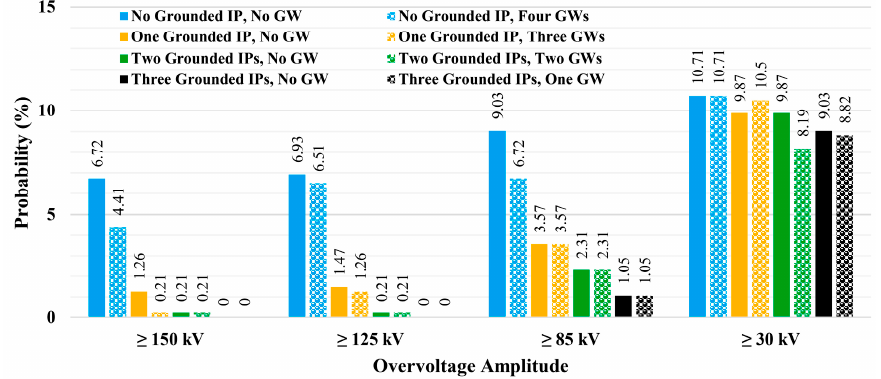
Figure 24. Comparison among the probabilities of transformers experiencing four overvoltage stress levels under different combinations of grounding and guy wire (GW) configurations of intermediate poles (IP); Network with wet arsenic-impregnated poles.